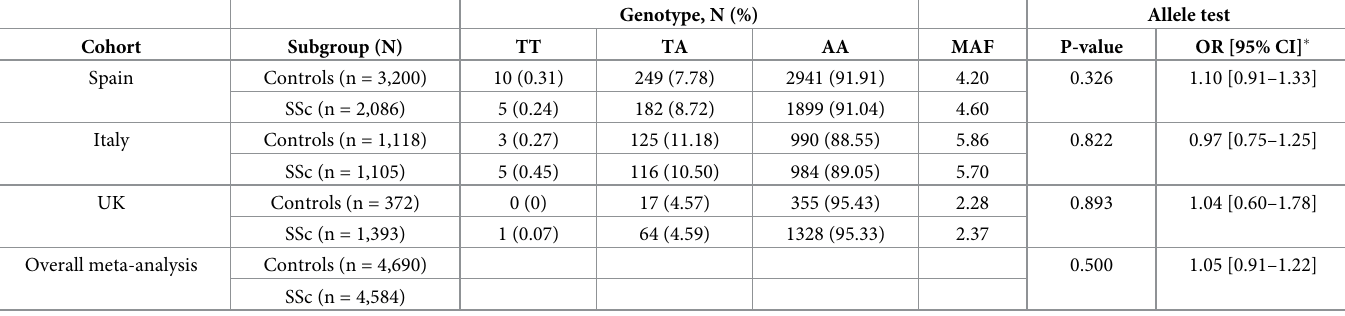
Table 3. Association analysis of the TNFSF13B rs374039502 variant in three independent SSc cohorts and